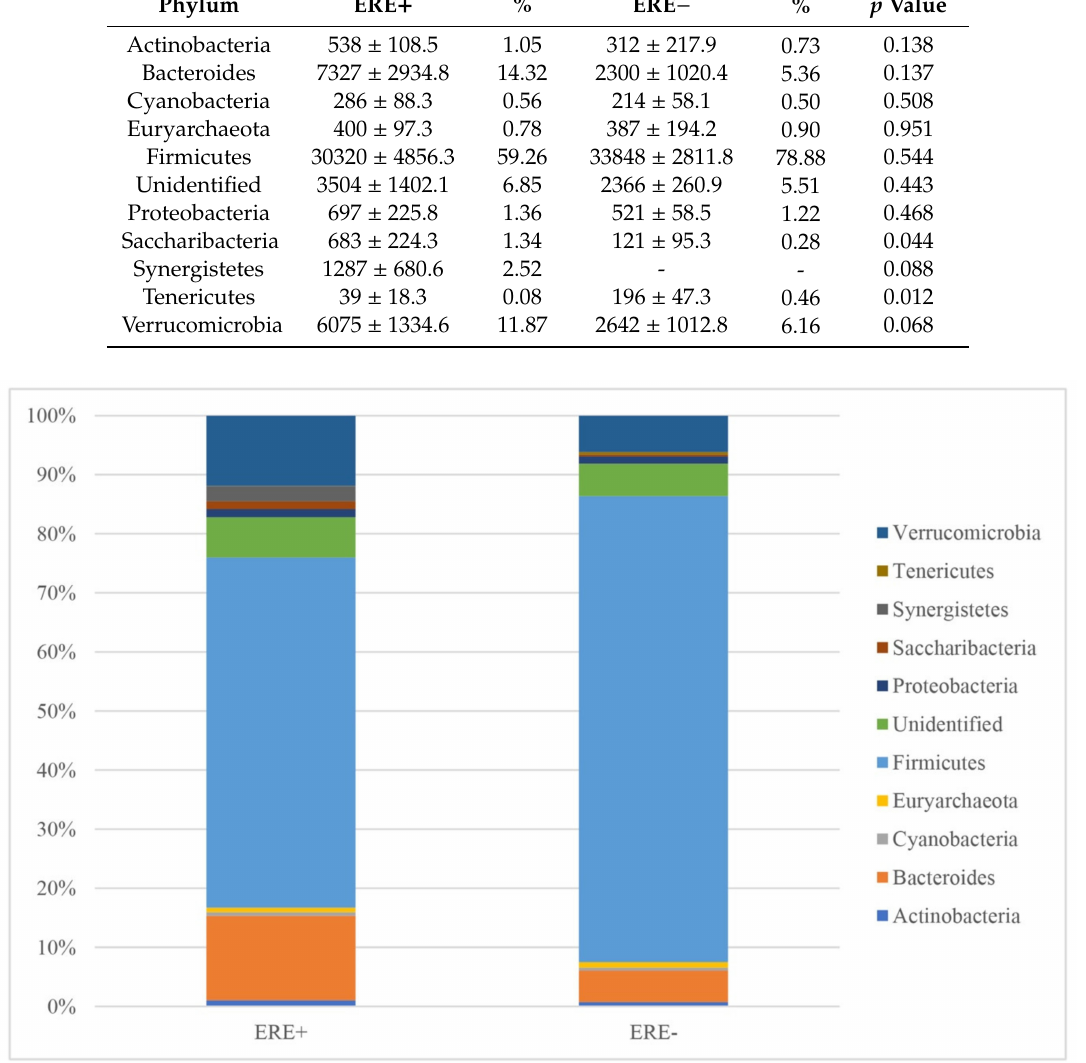
Figure 4. The relative abundance of bacterial genera in cecal samples of healthy and ERE rabbits. ERE + : Rabbits positive for epizootic enteropathy. ERE − : Healthy